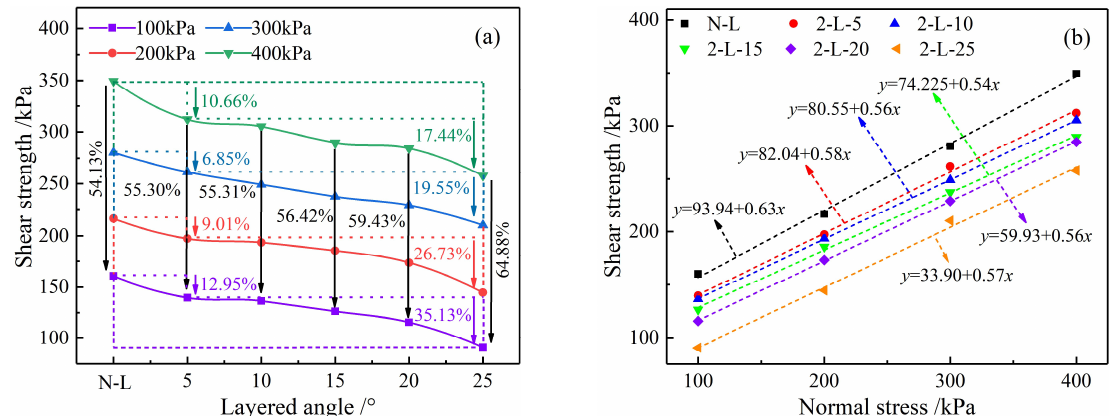
Figure 9. Analysis of shear strength. ( a ) Influence of layered angle on shear strength ( b )